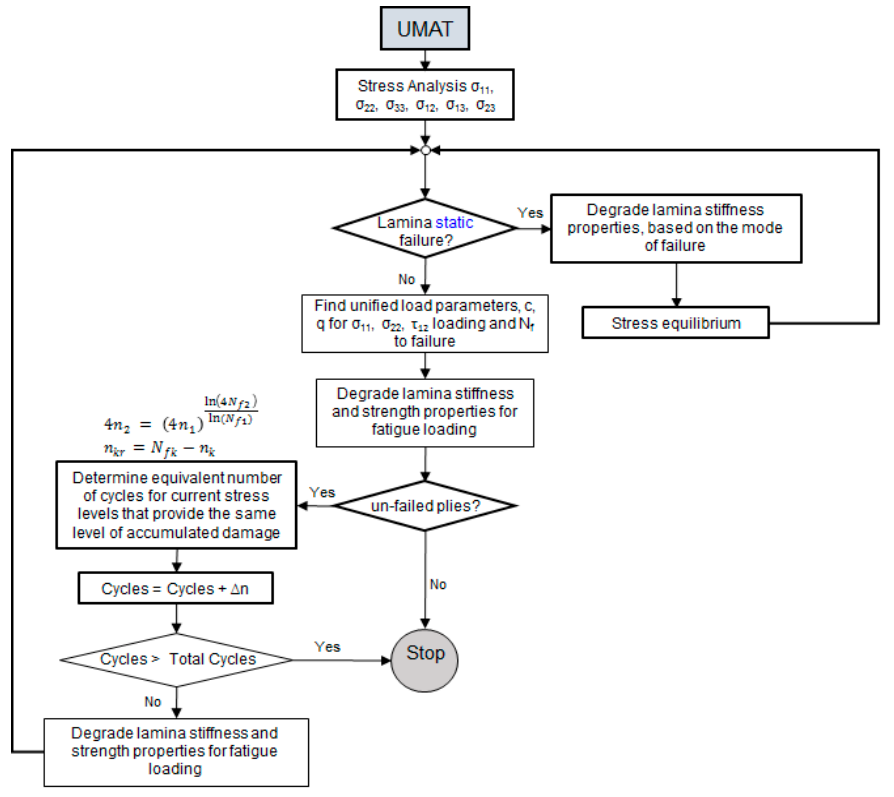
Figure 6. Flow chart of the FEM implementation using UMAT subroutine.